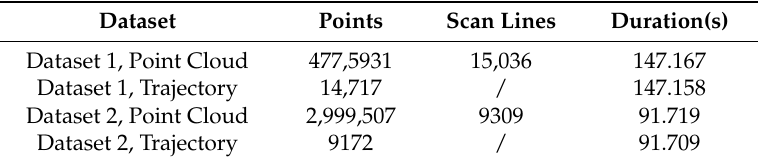
Table 1. Datasets used in this research.